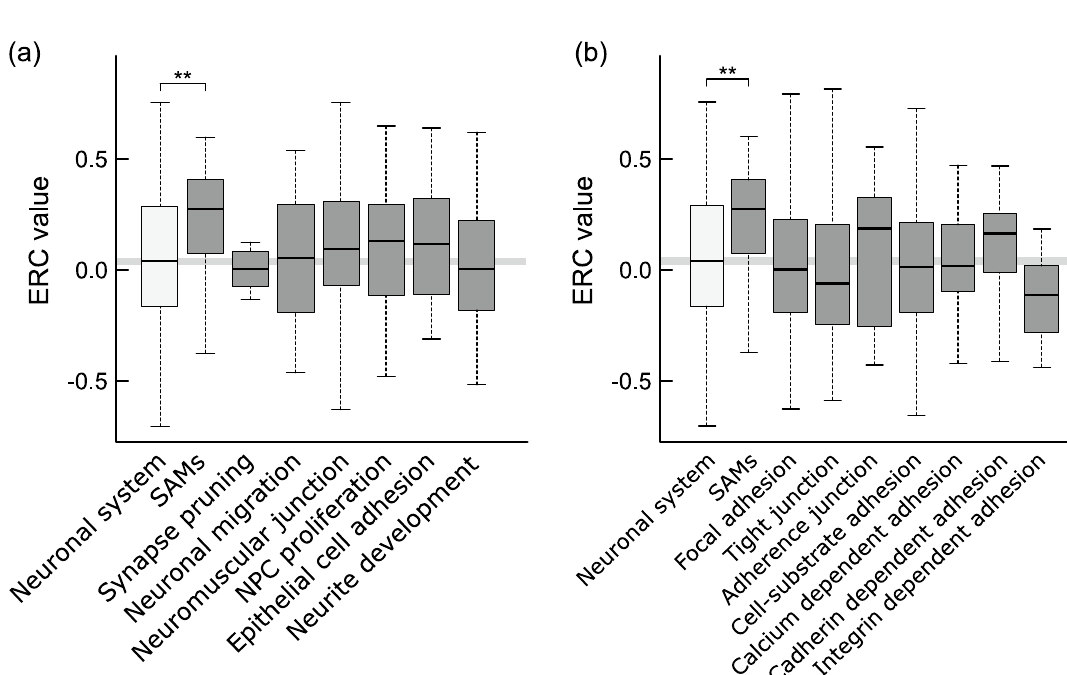
Figure 6. Comparison of coevolutionary analysis of APLP1, SAMs, and other neuronal-system related pathways. APLP1 has a statistically significant high ERC value with SAM proteins compared to that of neuronal system proteins. SAM: Synaptic adhesion molecule, NPC: Neural precursor protein. No such trend was detected for APP or APLP2 (Supplementary Table 4) (**P-value < 0.05 using one-tailed Dunnett’s test; regarding neuronal system as control